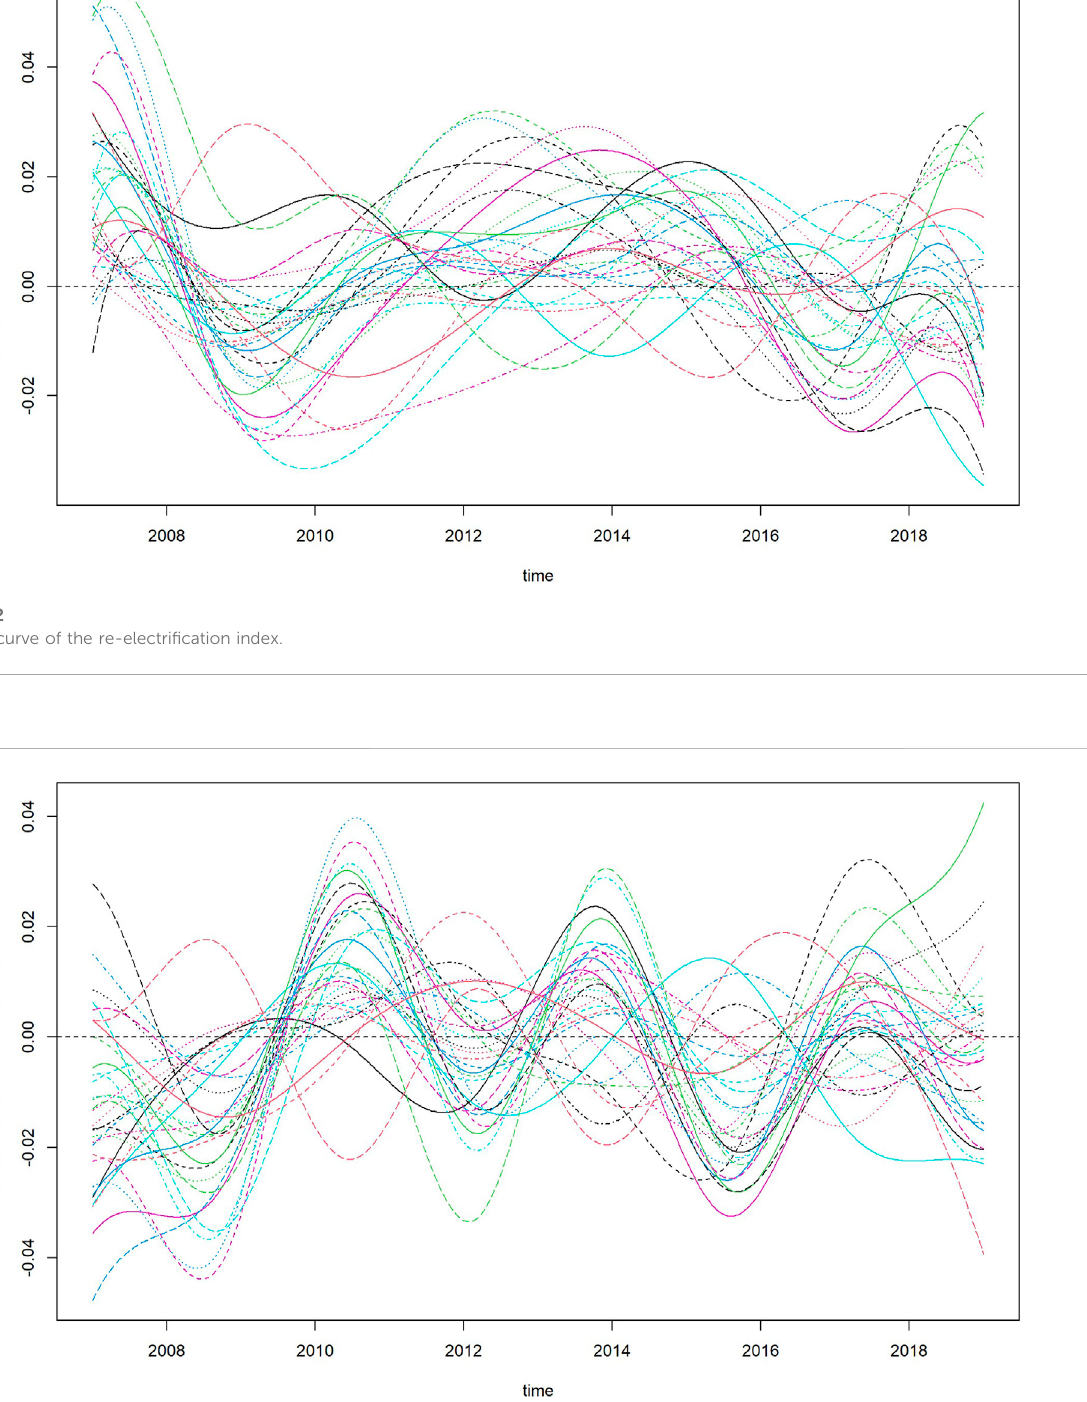
FIGURE 3 Acceleration curve of the re-electri fi cation